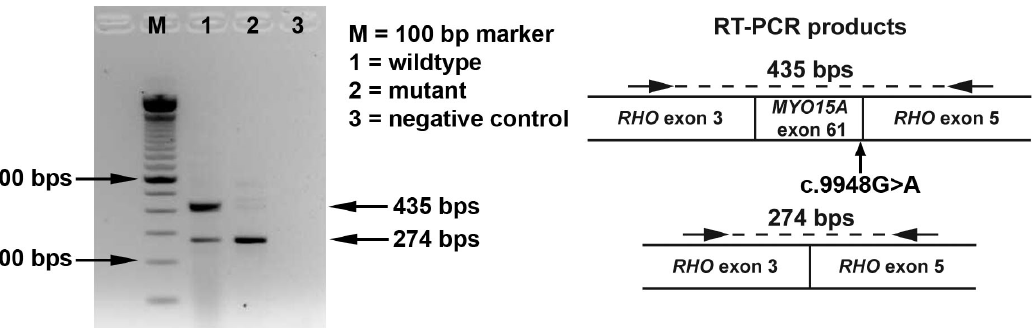
Figure 2. Effect of MYO15A c. 9948G . A using a minigene approach. An agarose gel containing RT-PCR products detected from HEK293T cells transfected with the wildtype and mutant minigene construct and a schematic representation of the identified splicing products. The RT-PCR products were verified by sequence analysis. The c.9948G . A mutation leads to skipping of exon 61.